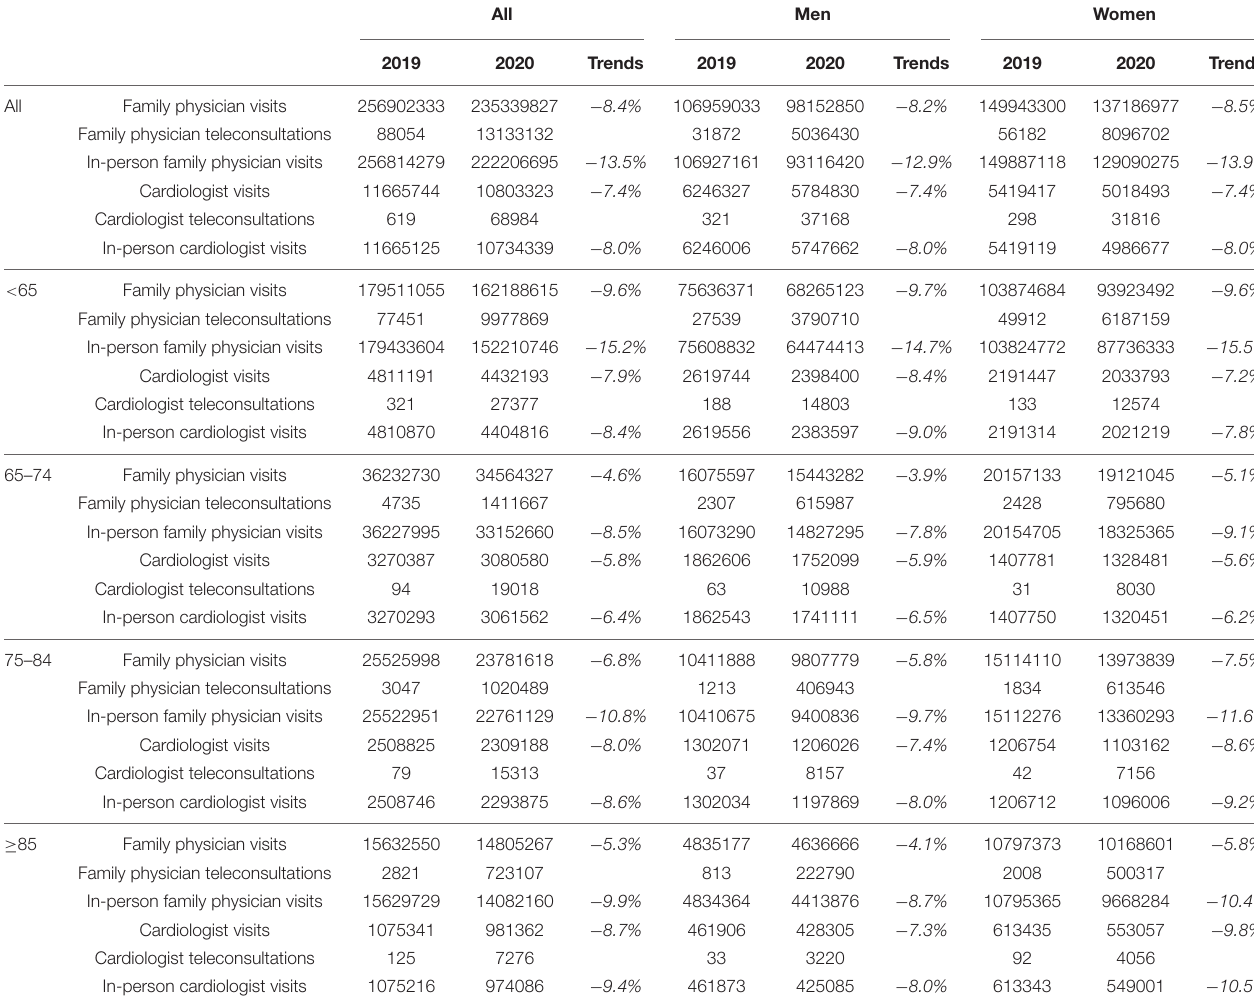
TABLE 2 | Numbers and 2019–2020 time trends (%) of family physician and cardiology visits according to sex, age, and type of visit (in-person visit or teleconsultations). All